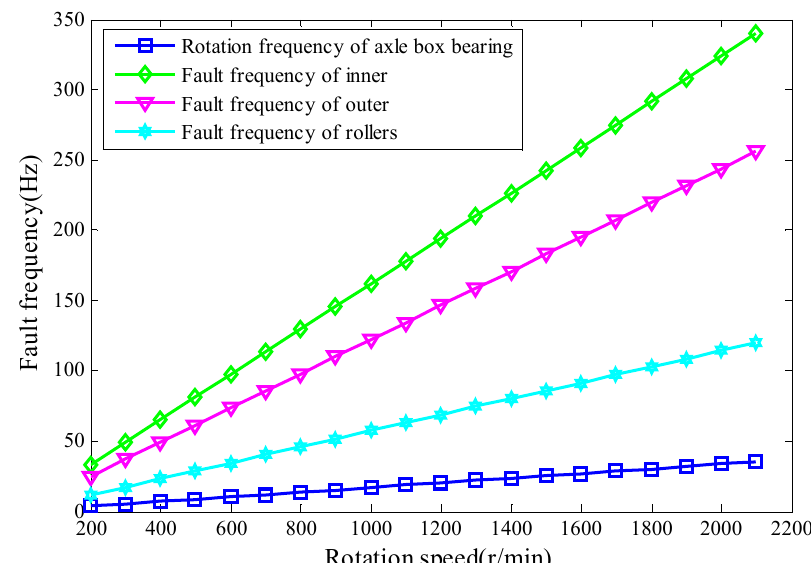
Figure 3. Failure characteristic frequency of axle box bearings at different rotational speeds.